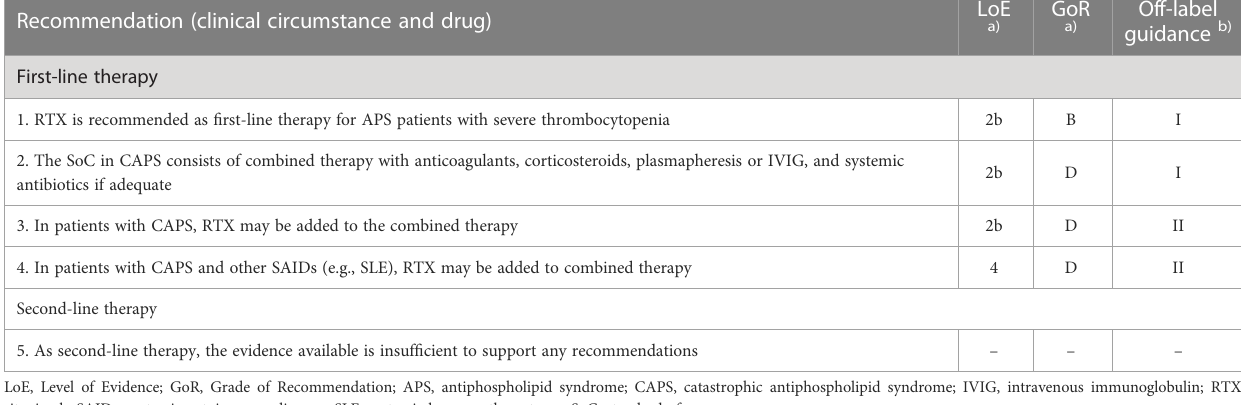
Recommendation (clinical circumstance and drug)